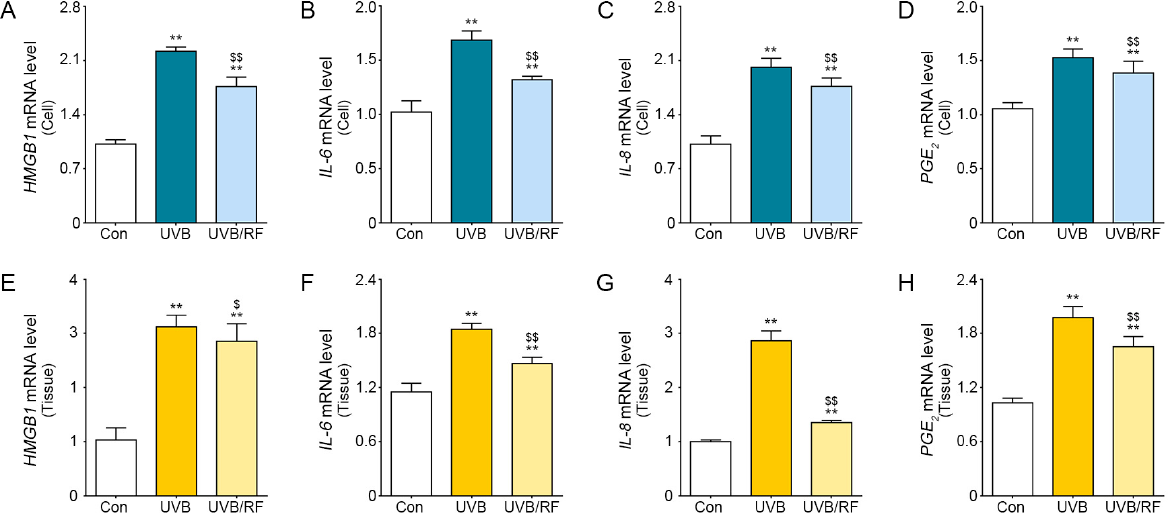
Figure 1. The inhibitory effects of radiofrequency (RF) irradiation on the expression of inflammatory cytokines from ultraviolet B (UVB)-radiated keratinocytes. The graphs show mRNA levels of inflammatory-related genes, including high-mobility group box 1 (HMGB1), interleukin (IL)-6, IL-8, and prostaglandin E 2 (PGE 2 ), in UVB-radiated ( A – D ) human primary epidermal keratinocytes (HEKn) and ( E – H ) mouse skin. All levels were confirmed by qRT-PCR. ** p < 0.01 vs. Con group; $ p < 0.05 and $$ p < 0.01 vs. UVB group. Results are presented as means ± standard deviations. Con, sham control; HEKn, human primary epidermal keratinocytes; HMGB1, high-mobility group box 1; IL, interleukin; mRNA, messenger RNA; PGE 2 , prostaglandin E 2 ; qRT-PCR, quantitative real-time polymerase chain reaction; RF, radiofrequency; UVB, ultraviolet B.